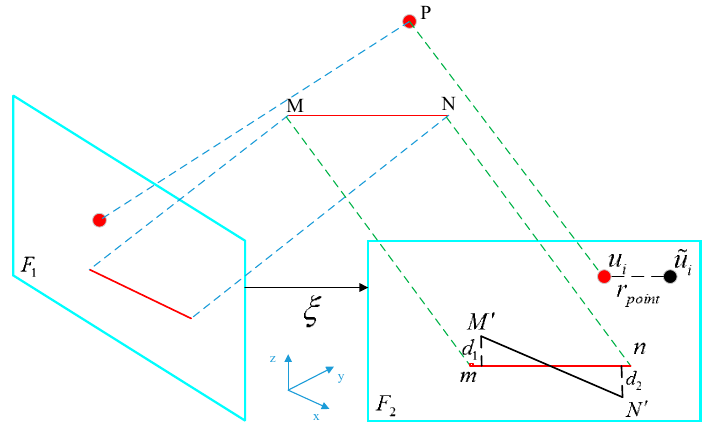
Figure 2. The graphic interpretation of the point/line feature reprojection error.